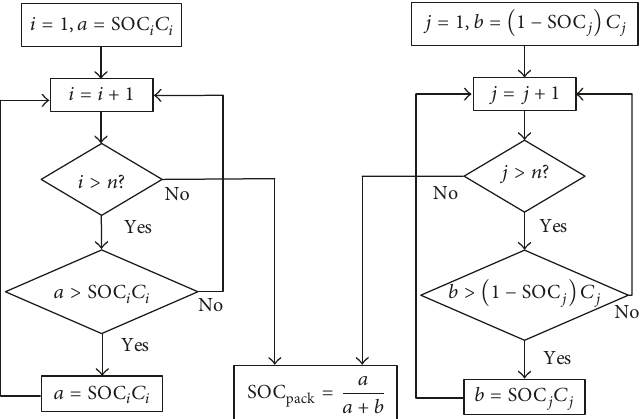
Figure 10: The calculation flow chart of SOC pack